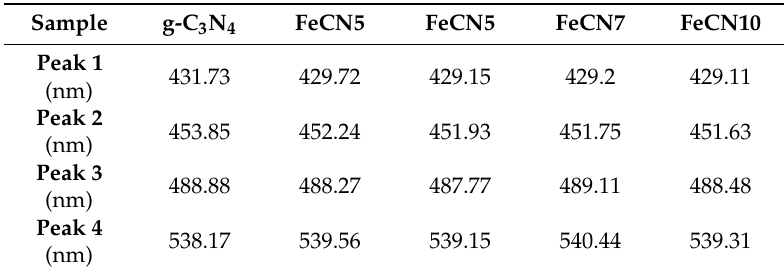
Figure 7. ( a ) Photoluminescence (PL) spectra of Fe-doped g-C 3 N 4 nanosheets with different Fe concentrations and ( b ) The normalized PL spectra and the Gaussian fitting for pure g-C 3 N 4 . Table 2. The Position of Photoluminescence Peaks P1, P2, P3, P4 of Fe-Doped g-C 3 N 4 Nanosheets with Different Fe Concentrations.